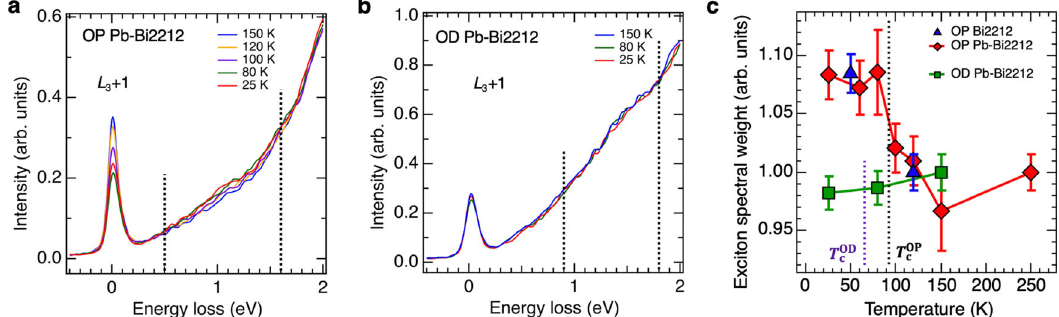
Fig. 4 | Evolution of the exciton spectral weight across the superconducting transition. a , b Cu L 3 -edge RIXS induced by incident photons of energy tuned to 1eV above the L 3 absorption energy with Q ∥ =( π , 0) for OP and OD Pb-Bi2212, respectively.Thenormalizationschemeofspectraisthesameasthosedescribedin Figs.2and3.Thedottedlinesindicatetheenergyrangeselectedforspectral-weight integration. c Evolution of theexcitonspectralweightde fi ned astheintegrationof RIXS between 0.5 and 1.6eV for OP and between 0.9 and 1.8eV for OD samples,